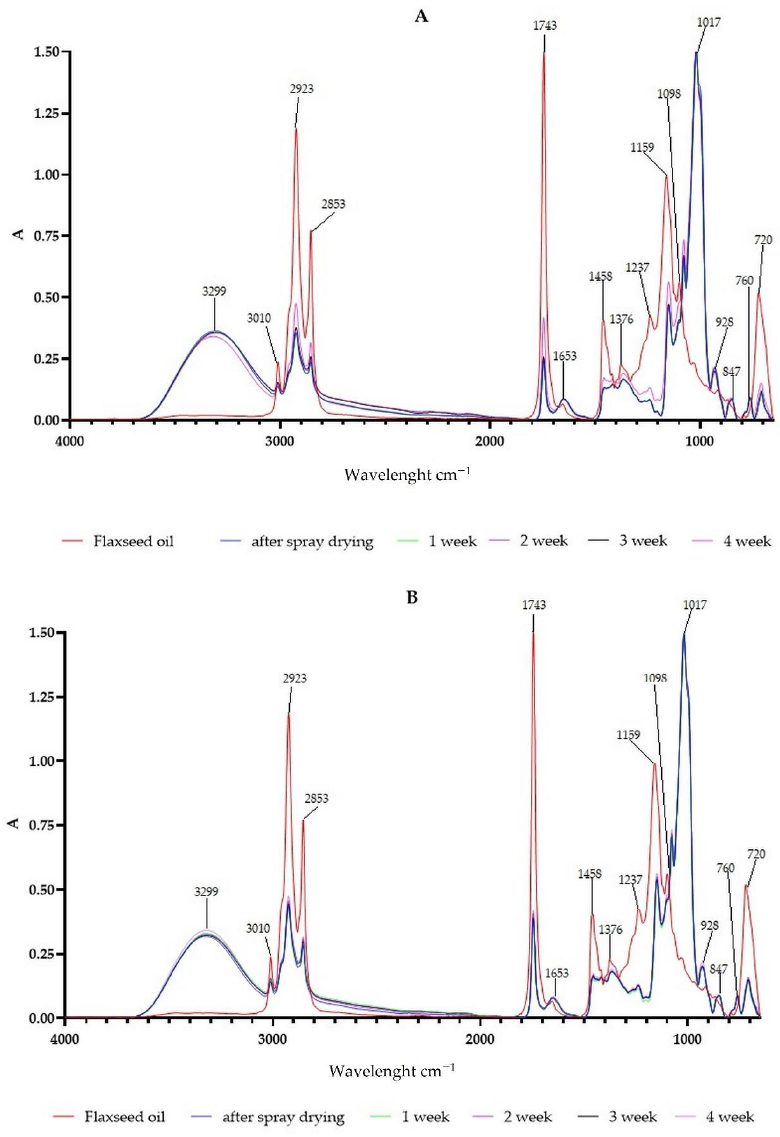
Figure 2. FTIR spectra of fresh flaxseed oil, powders with 10% ( A ) and 20% ( B ) and flaxseed oil, directly after spray drying, and after 1, 2, 3, and 4 weeks of storage.